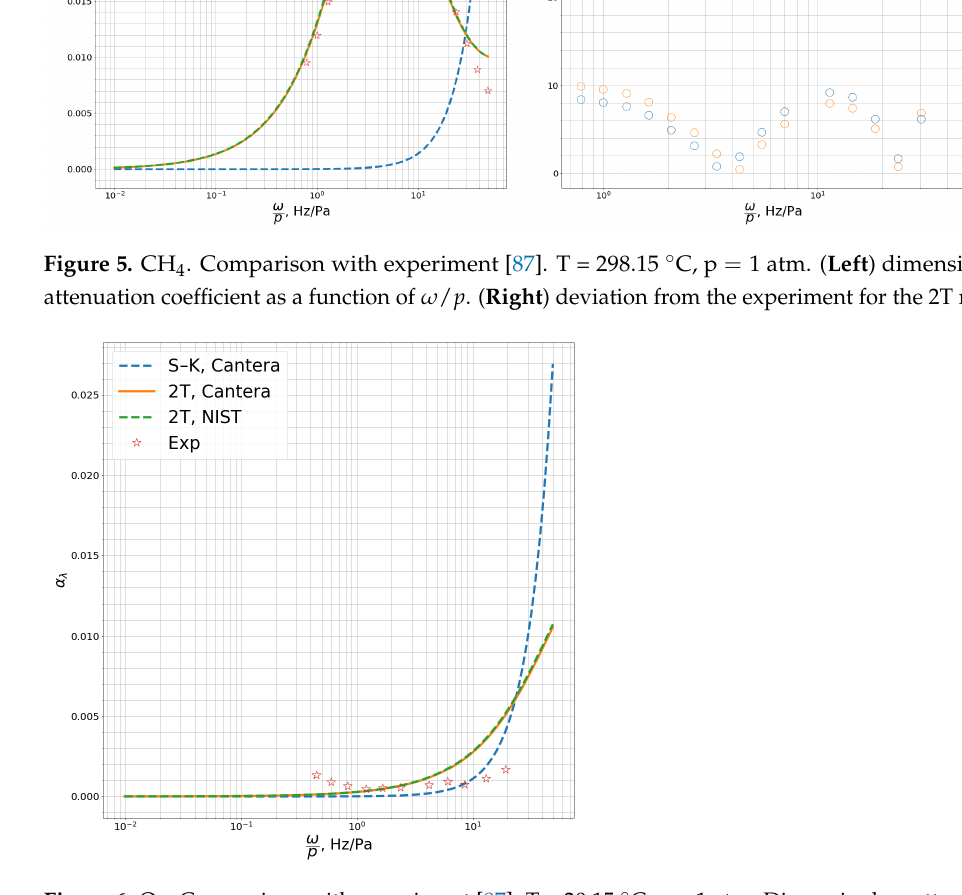
Figure 6. O 2 . Comparison with experiment [87]. T = 20.15 ◦ C, p = 1 atm. Dimensionless attenuation coefficient as a function of ω / p